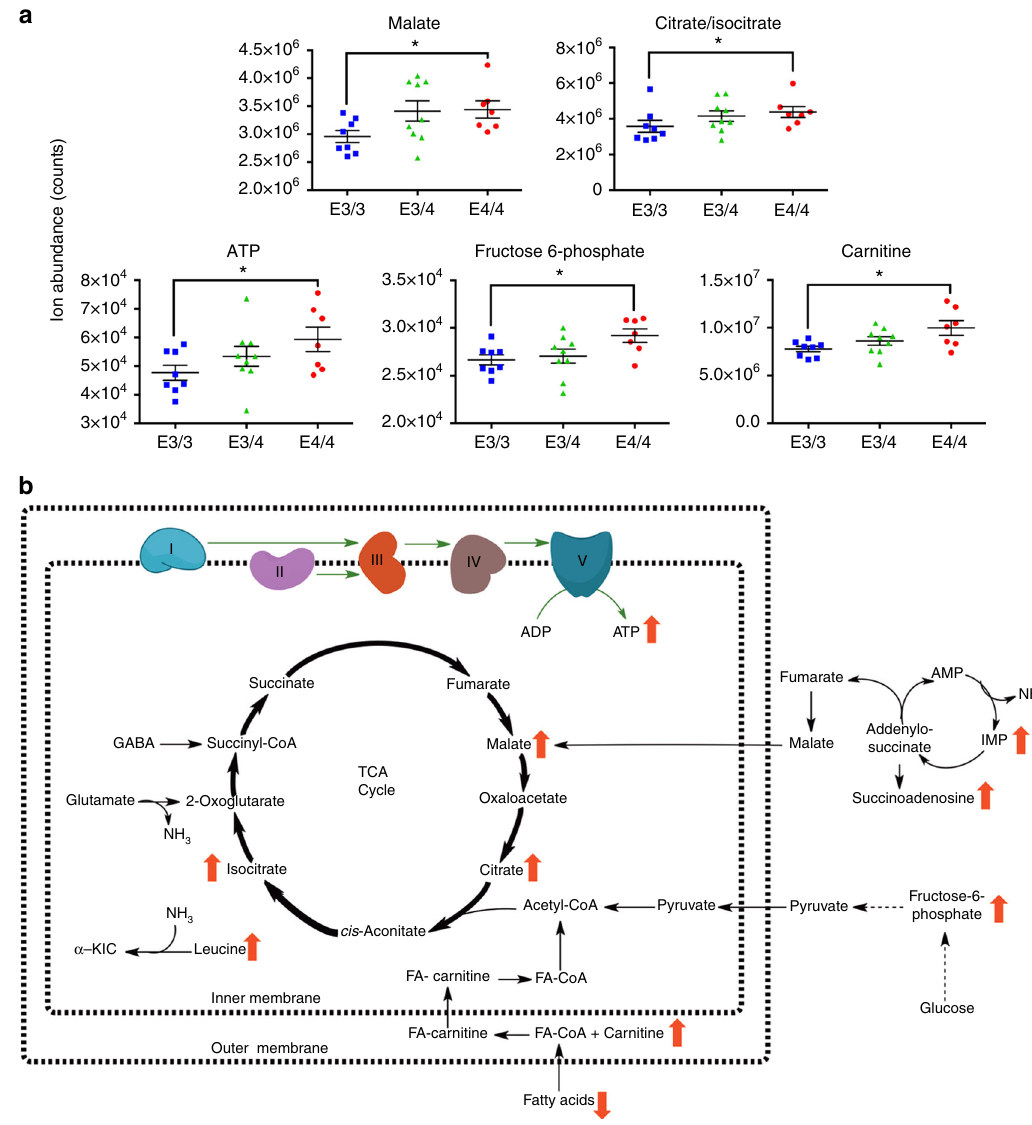
Fig. 3 APOE4 is associated with increased expression of small molecules related to energy metabolism. Targeted metabolite pro fi ling was performed on small-molecule metabolites extracted from the EC and PVC of aged APOE mice (14 – 15 months old; 8 APOE3/3 , 9 APOE3/4 , and 7 APOE4/4 males). a Scatter dot plots depicting metabolite abundance in the EC for fi ve energy-related metabolites found to be upregulated (Mann – Whitney; malate, p = 0.037; citrate/isocitrate, p = 0.028; ATP, p = 0.049; fructose-6-phosphate, p = 0.011; carnitine, p = 0.021) in APOE4 EC (black lines represent mean values and SEM). b Schematic of the energy metabolism-related metabolites found to be dysregulation in APOE4 EC. (* p ≤